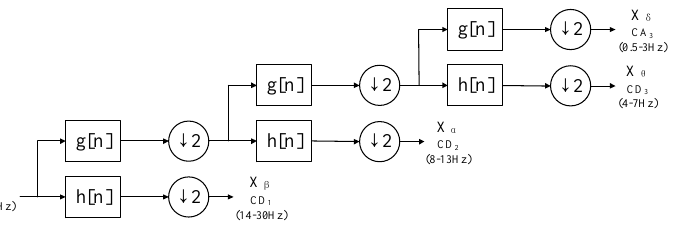
Figure 3. Wavelet decomposition. X : preprocessed EEG signal. h : high-pass filter. g : low-pass filter. Down arrow: subsampled by 2. CD i : detail coefficients. CA i : approximation